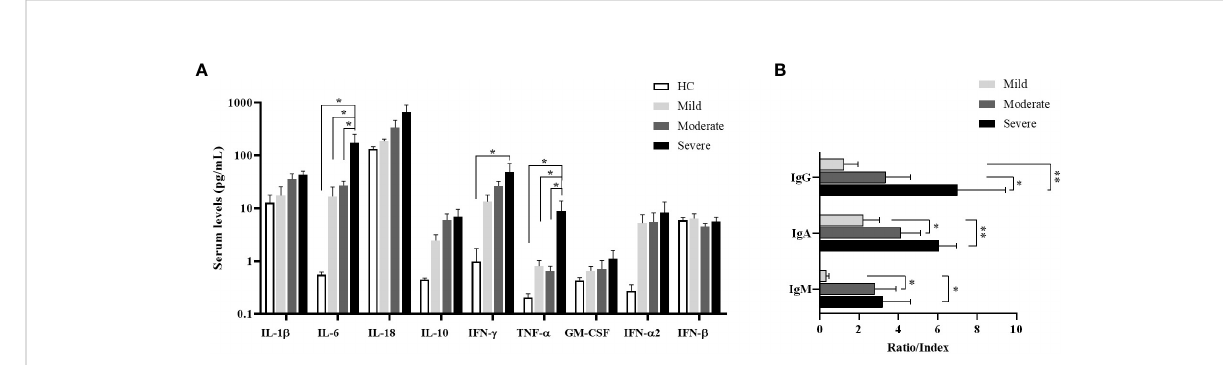
FIGURE 5 Cytokine measurement by multiplex assay in serum samples and determination of SARS-CoV-2-speci fi c antibody ratios. (A) IL-1 b , IL-6, IL-18, IL- 10, IFN- g , TNF- a , GM-CSF, IFN- a 2 and IFN- b levels in serum of patient groups and healthy controls were determined by multiplex assay. Statistical analysis was performed by ANOVA followed by Tukey ’ s test. (B) Anti-SARS-CoV-2-speci fi c IgM (nucleocapsid), IgG (spike) and IgA (spike) concentrations in serum samples of patient groups. *p<0.05, **p<0.001, HC, Healthy